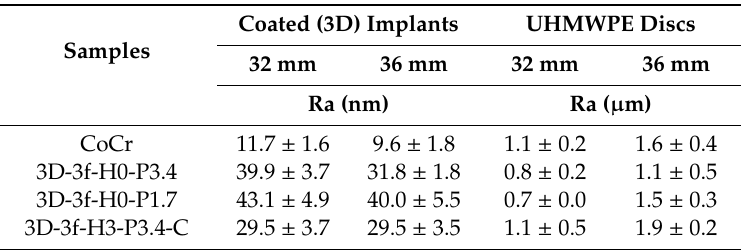
Table 4. Surface roughness of 3D coated, uncoated substrate and ultra-high molecular weight polyethylene (UHMWPE) discs used for reciprocal wear tests for 32 mm and 36 mm (average ± standard deviation).